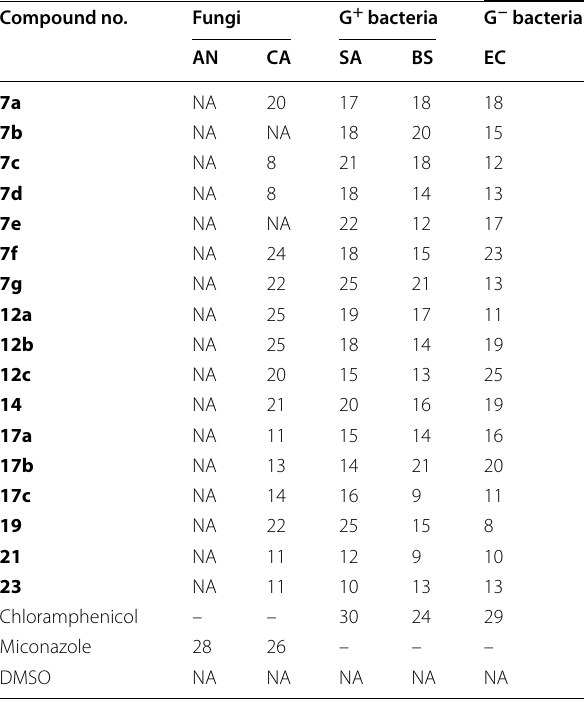
Table 1 Antimicrobial activity expressed as inhibition diameter zones in a centimeter (cm) of tested compounds against the pathogenically stains based on disk diffusion as the assay Compound